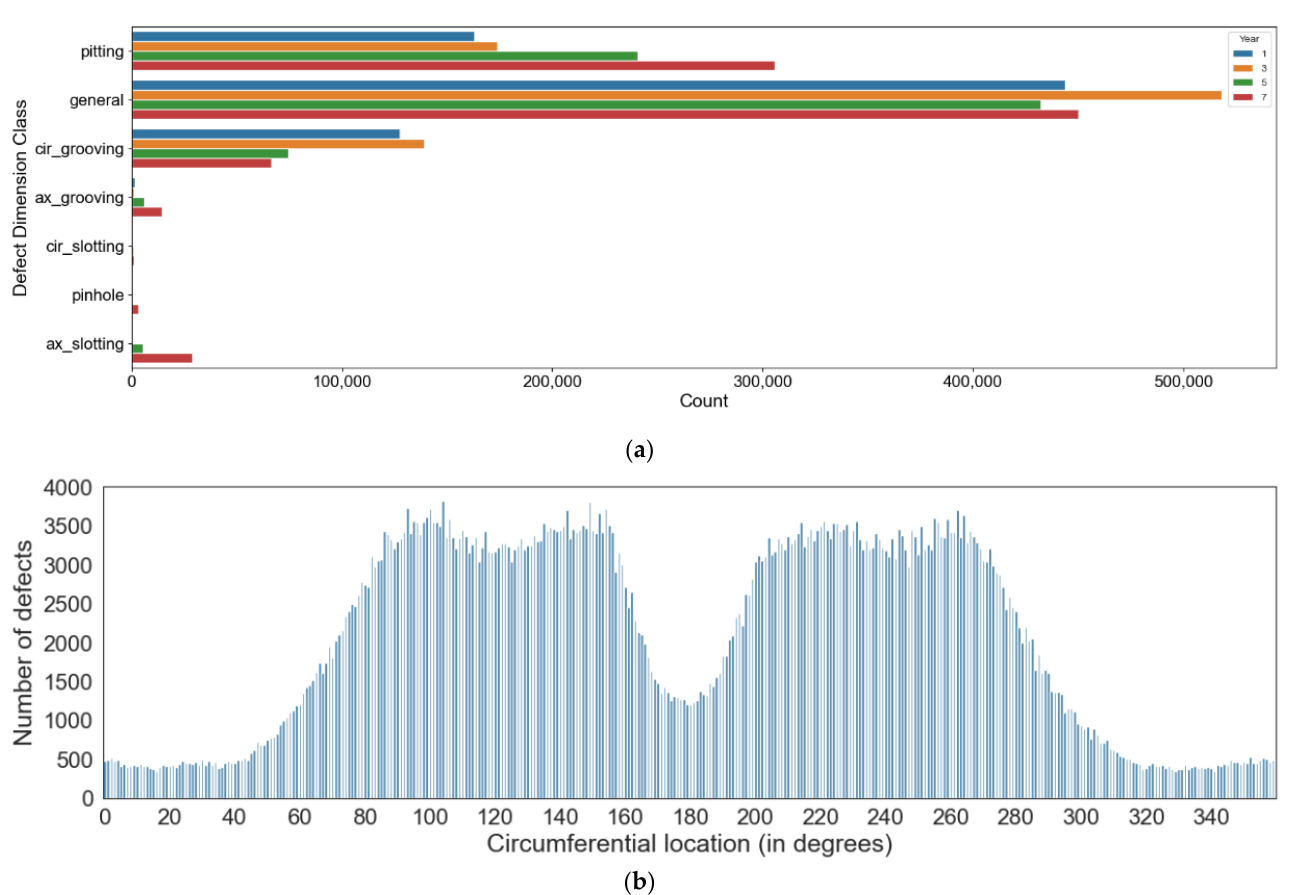
Figure 7. Visualisation of ILI dataset: ( a ) count of defect’s dimension class by the inspection year; ( b ) distribution of defect’s most significant point circumferential location (in degrees) for Year 7. Table 1. Statistics of normalised train and test datasets. Feature (mm)